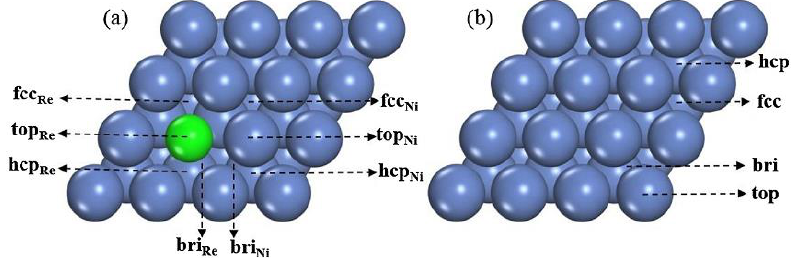
Figure 6. Adsorption sites existed in the ( a ) Re@Ni(111) and ( b ) Ni(111) surface. Ni: blue, Re: green, reprinted with permission from [32]. Copyright Elsevier, 2018.